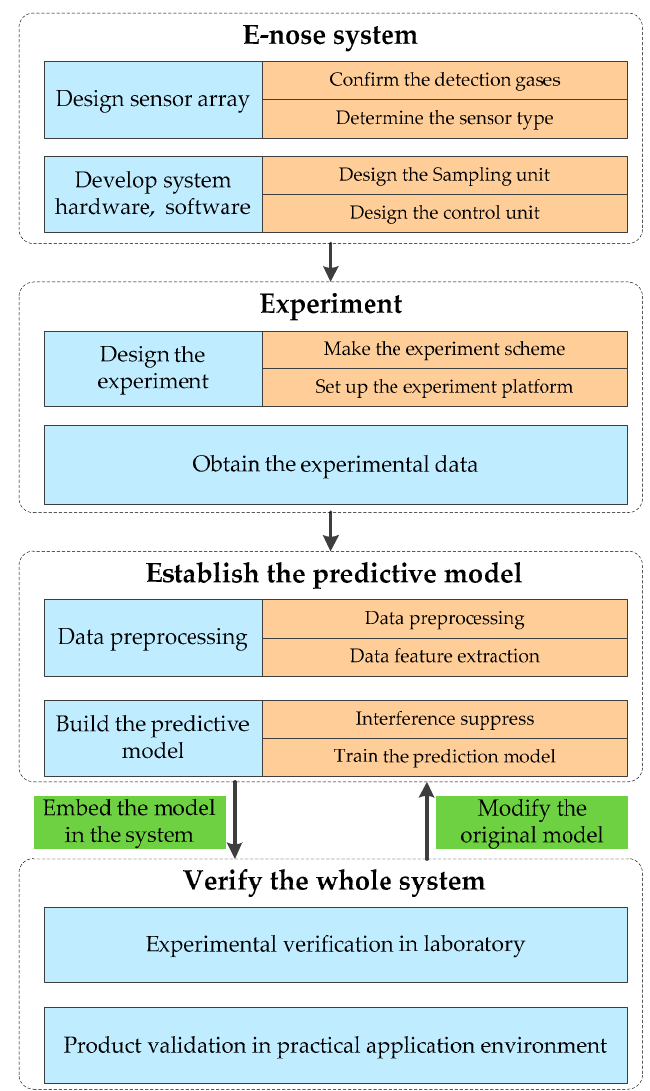
Figure 1. The design flow diagram of the e-nose system.